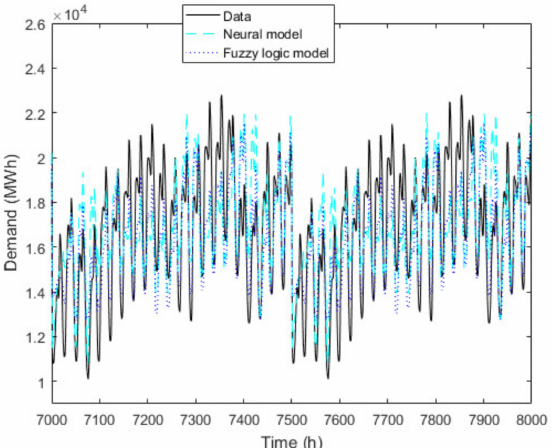
Figure 4. Generalization results of the first training dataset.